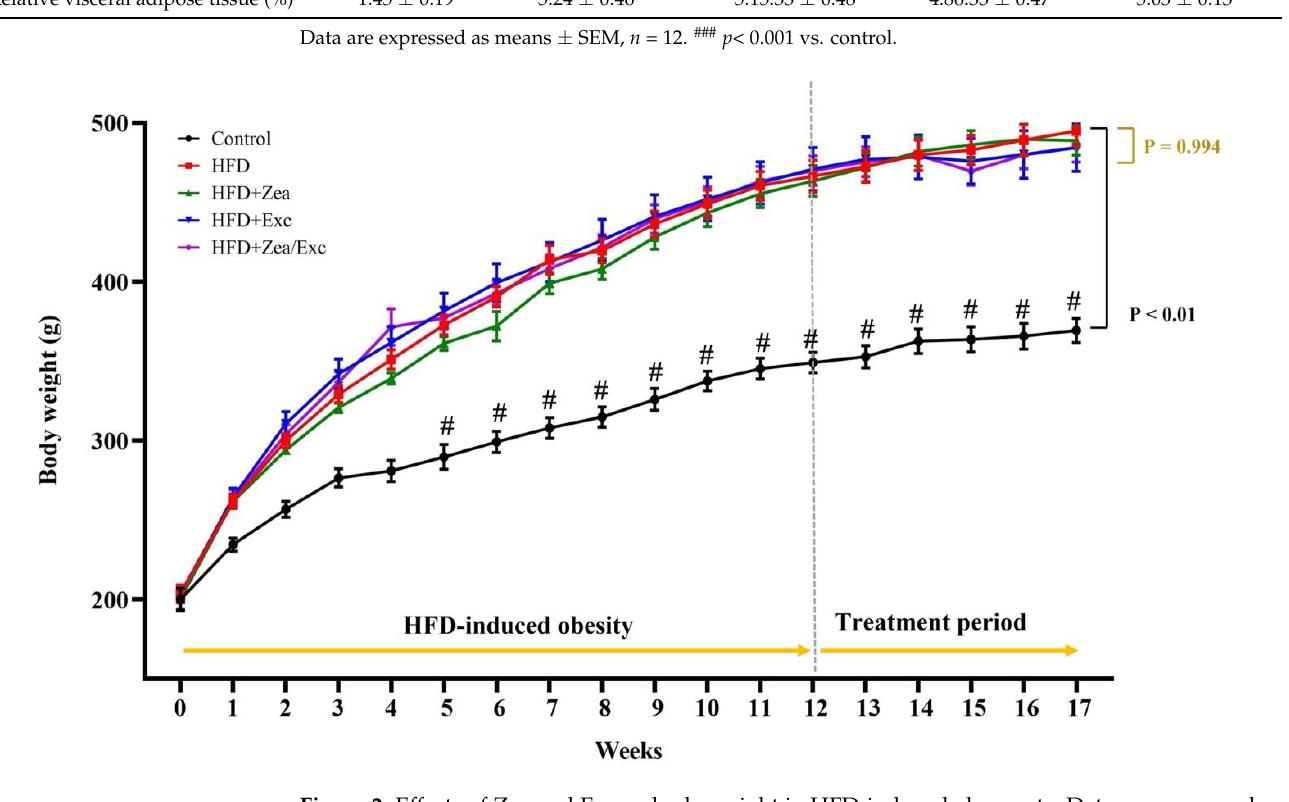
Figure 2. Effects of Zea and Exc on body weight in HFD-induced obese rats. Data are expressed as means ± SEM, n = 12. # p < 0.05 vs. control.